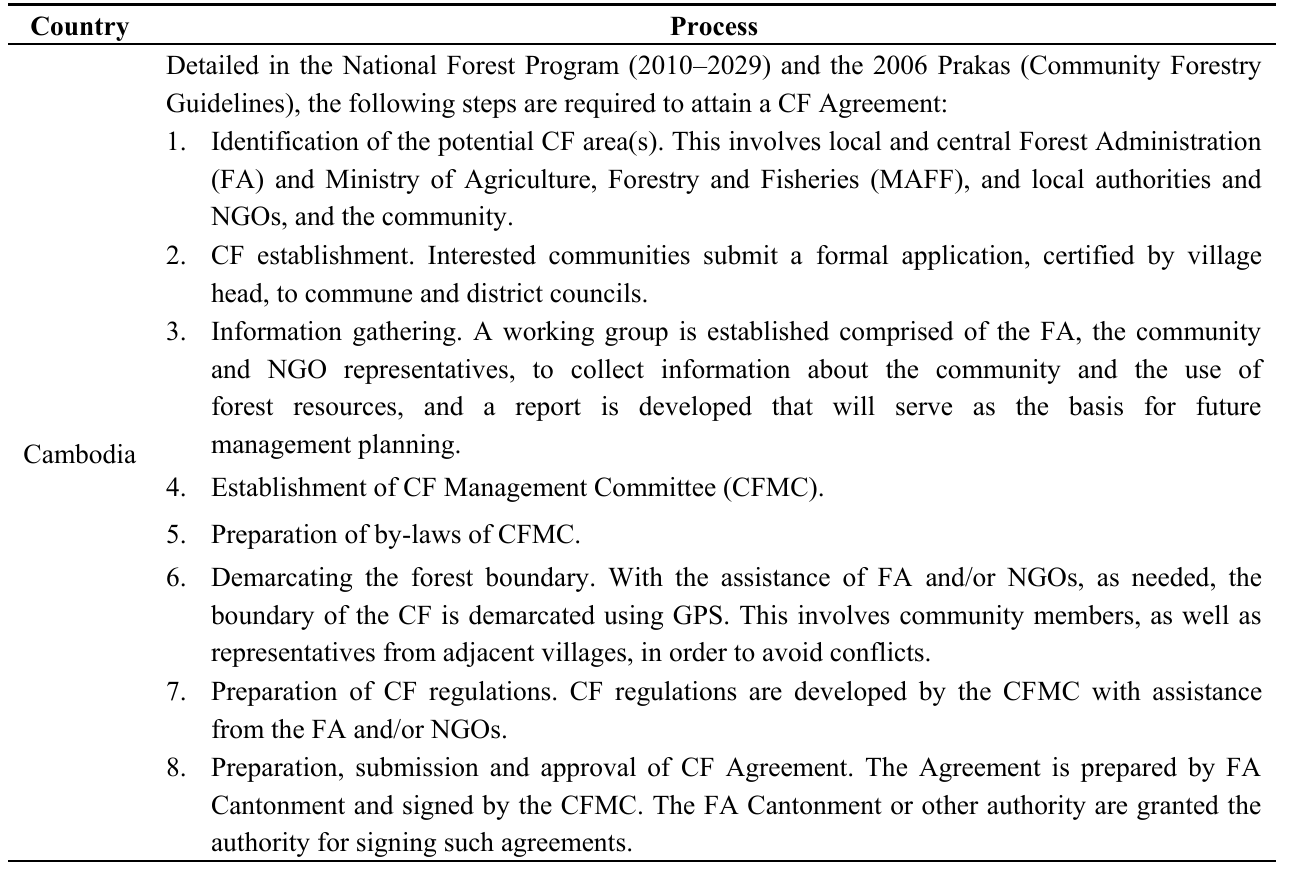
Table 2. Details of tenure certification process for each country